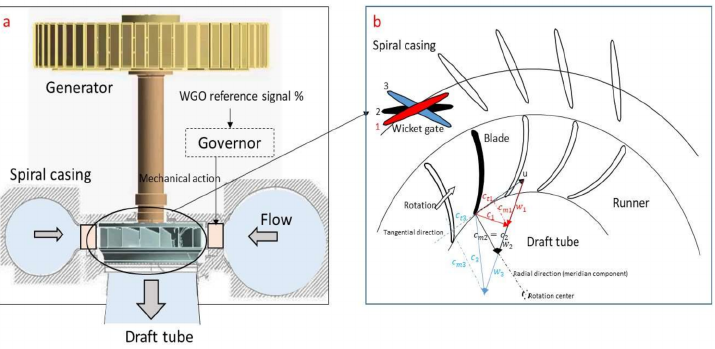
Figure 2. General description of the analyzed unit ( a ) and detail view of the runner velocities at the outlet of a generic Francis runner ( b ).